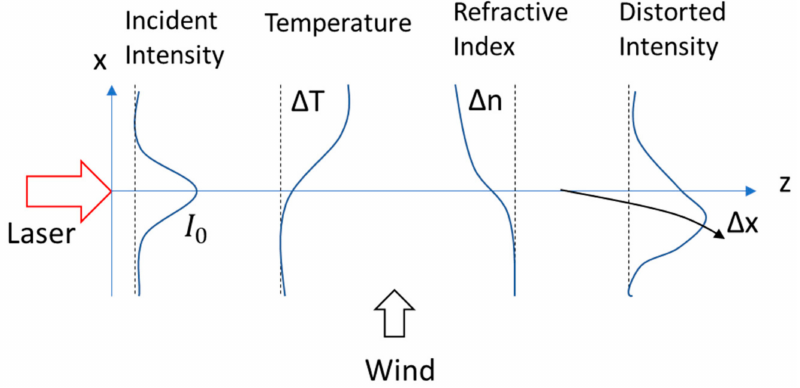
Figure 15. Thermal blooming with a transverse wind. Adapted from